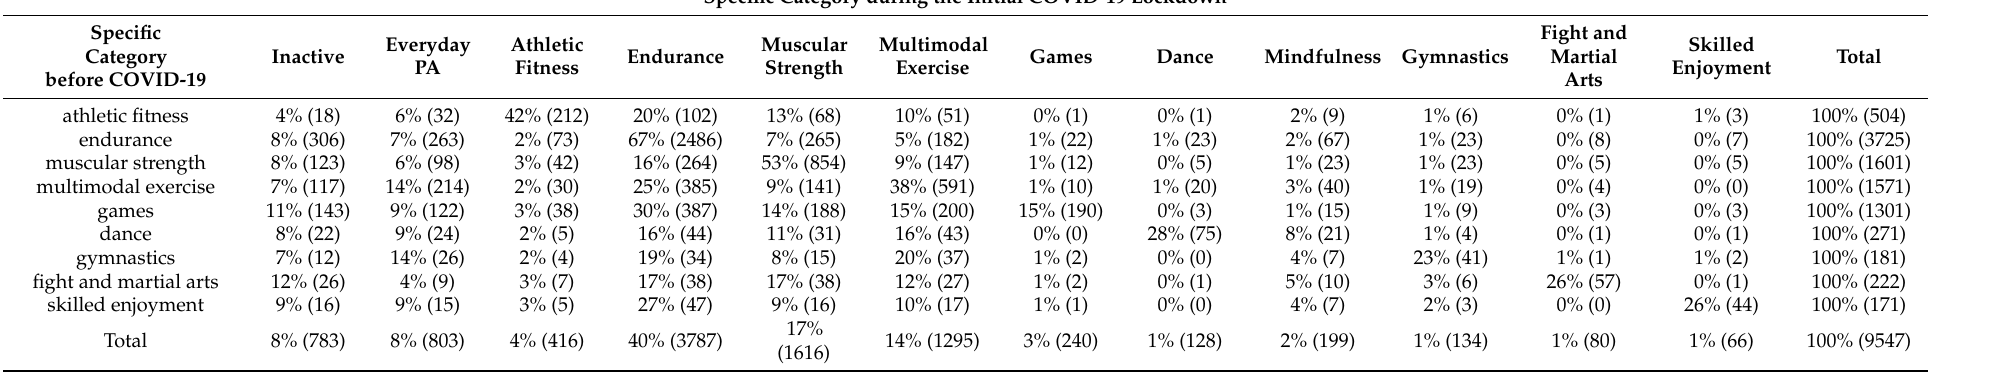
Table A3. Change in the specific category including exact numbers and percentages among participants that were categorized in the broad category of exercise/sport and mindfulness before